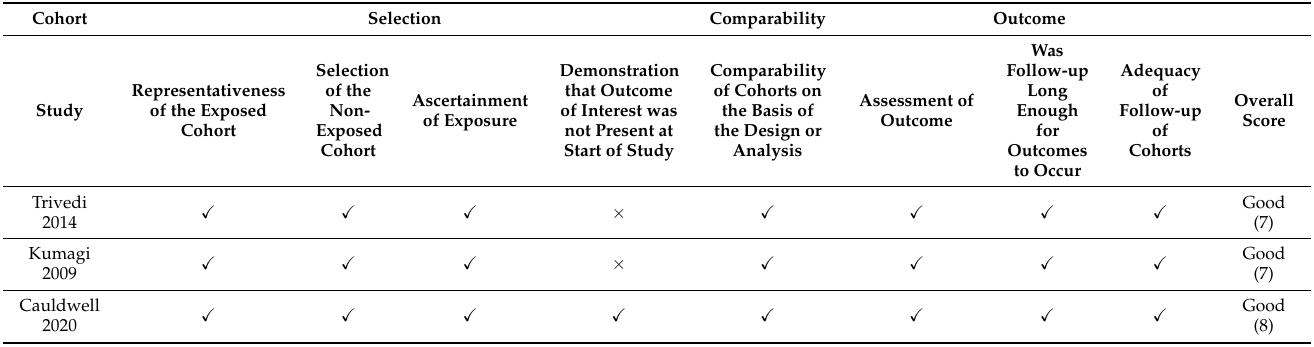
Table 6. Quality assessment of individual cohort studies using the Newcastle-Ottawa Scale.